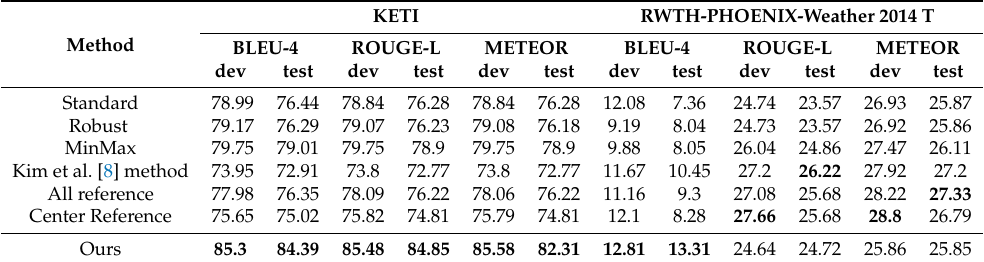
Table 2. Comparison Of Normalization